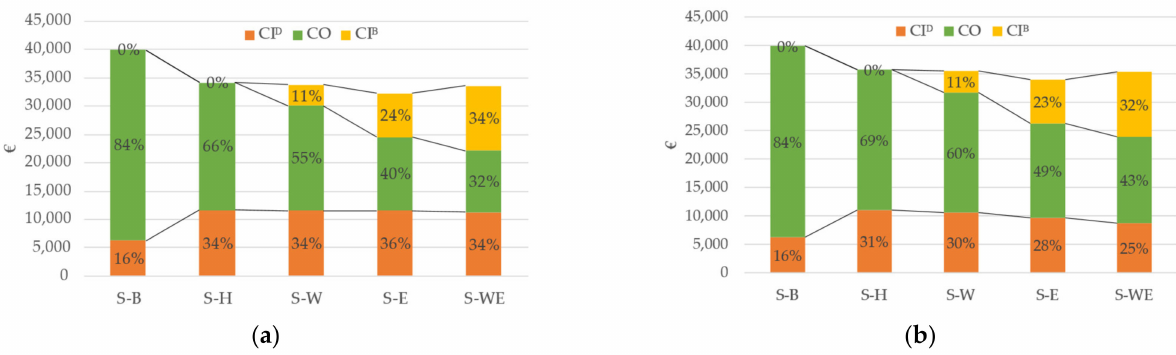
Figure 5. Optimal investments and operation results: ( a ) with incentives; ( b ) without